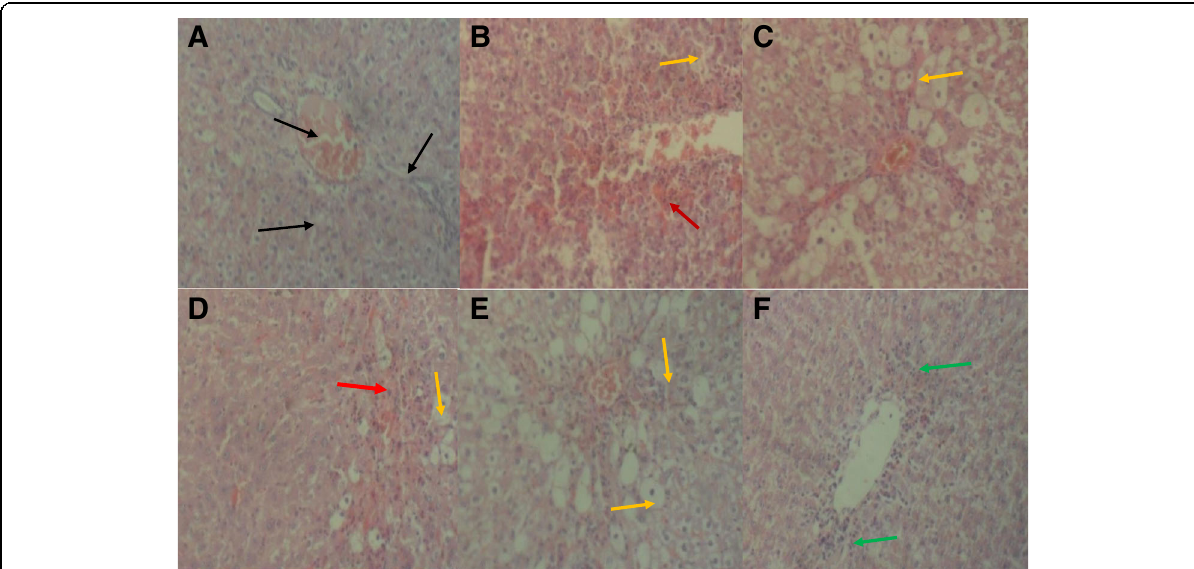
Fig. 9 Photomicrographs of liver sectionsfrom a Control rats showing normal liver histology: Black arrow heads indicatenormal portal vein and hepatocytes with well fenestrated sinusoidal space, b rats intoxicated with CCl 4 on the 8th day c rats treated with 250 mg/kg bw.TC seed for 7 days,thereafter intoxicated with CCl 4 on the 8th day d rats treated with 500 mg/kg bw.TC seed for 7 days,thereafter intoxicated with CCl 4 on the 8th day e rats intoxicated with CCl 4 and then given methanol extract of TCseed (250 mg/kg body weight orally) at 1 h, 6 h, 12 h, 18 h and 24 h f rats intoxicated with CCl 4 and then given methanol extract of TCseed (500 mg/kg body weight orally) at 1 h, 6 h, 12 h, 18 h and 24 h. The liver sections were stained with H/E and observed with a 10X objective. Arrow heads (Orange): Vesicular steatosis/fatty accumulation; (Dark Red): Extensive hemorrhagic necrosis; (Light Red): Mild hemorrhagic necrosis; (Green): Mild portal hepatitis. TC: Tetracarpidium